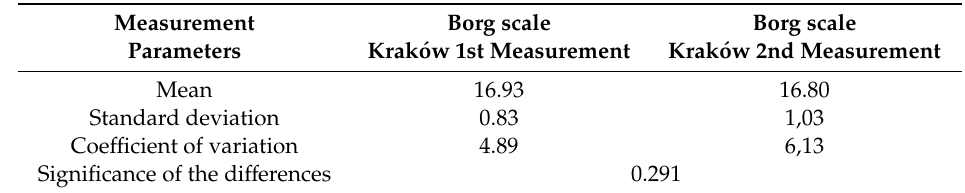
Table 2. Assessment of the subjective level of fatigue of the tested individuals in the Borg scale for the first and second study in Krakow.